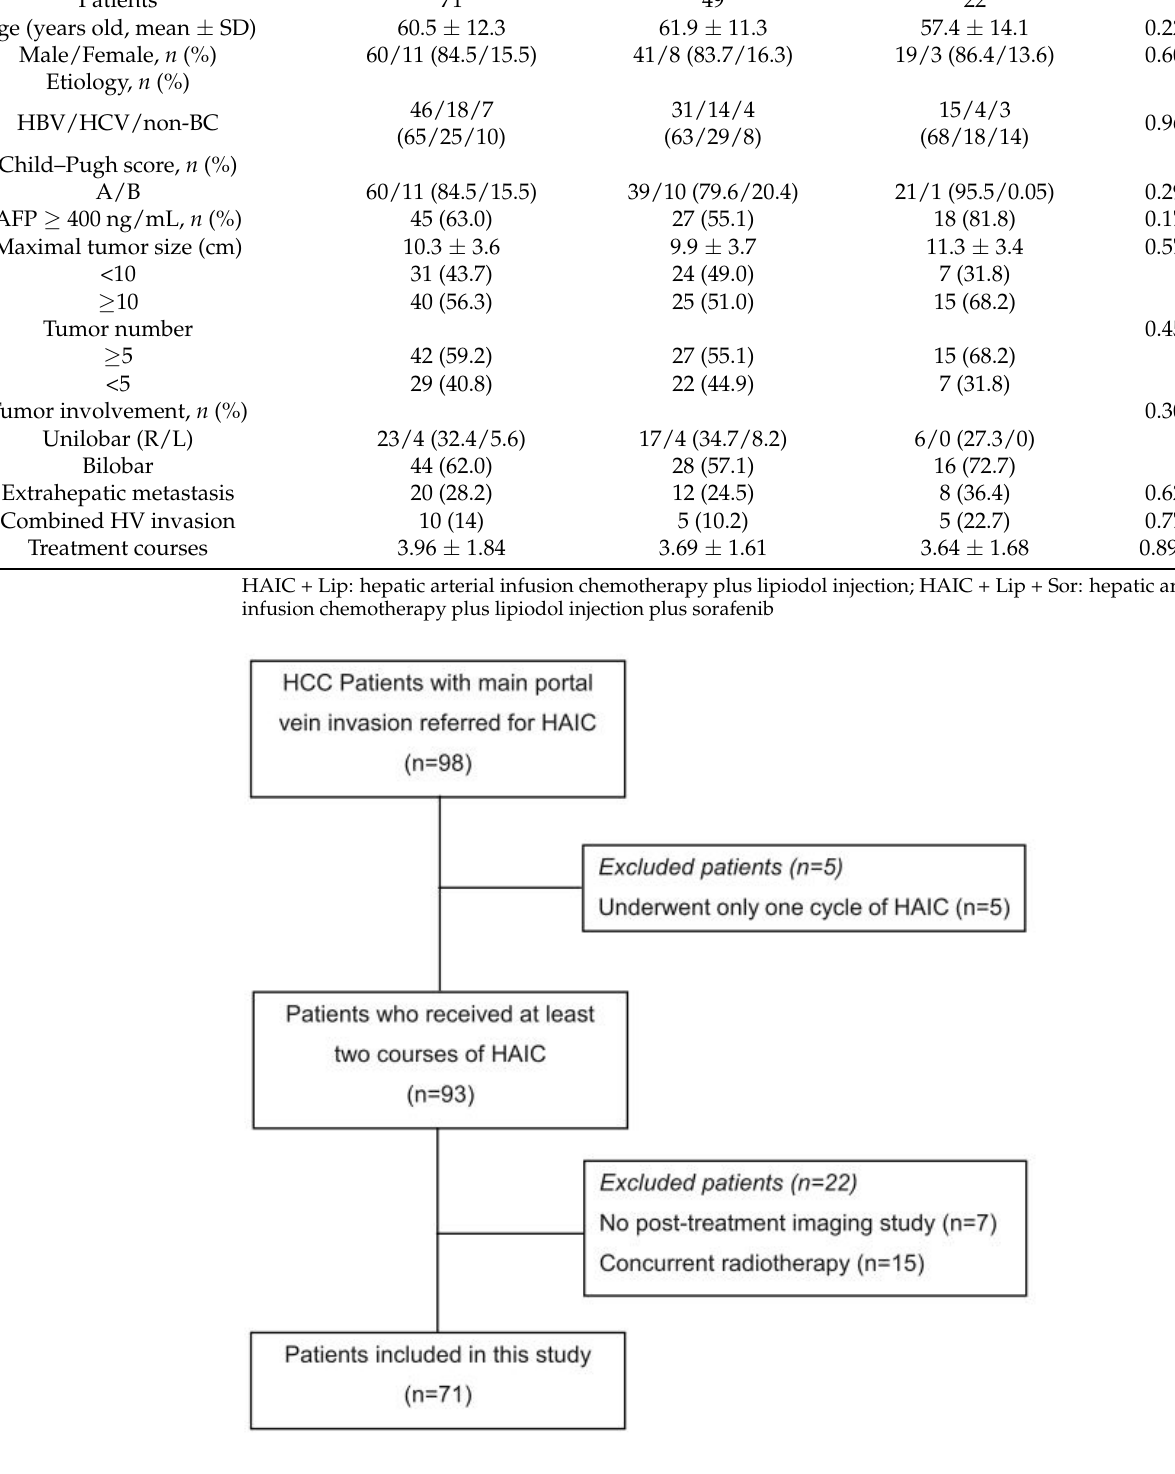
Figure 1. Flow chart of patient inclusion and exclusion.